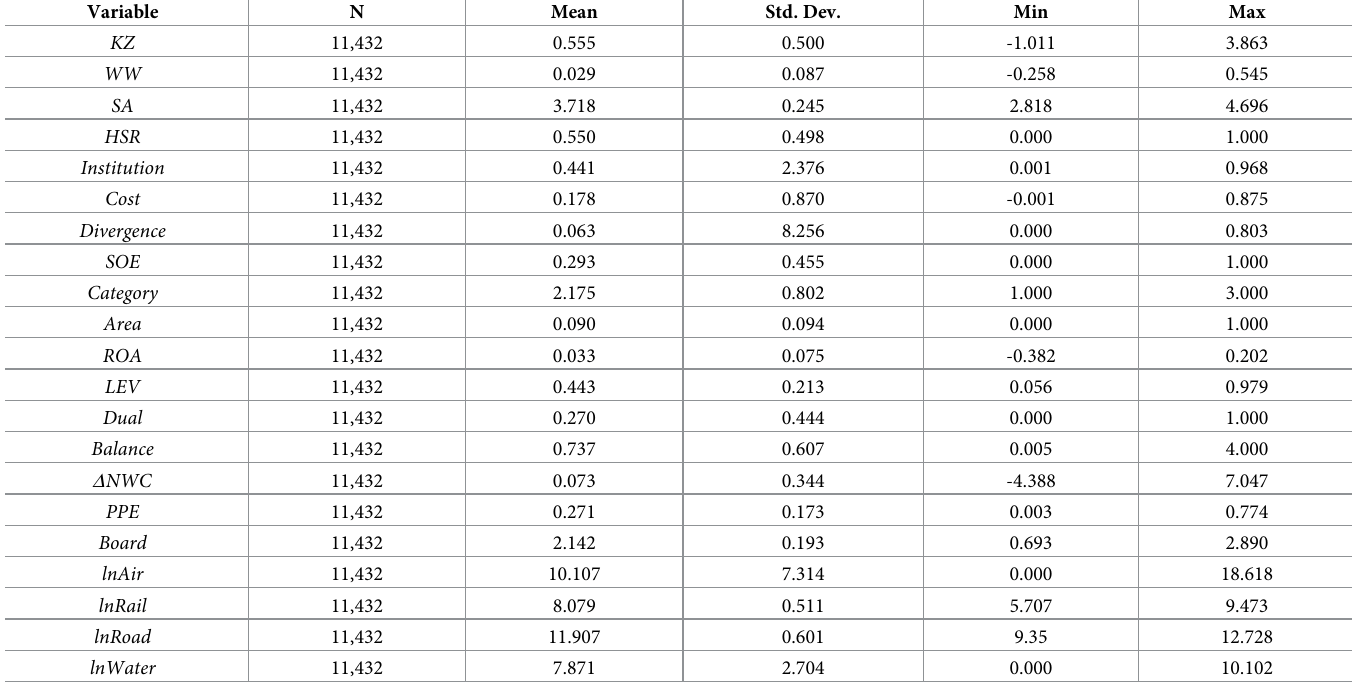
Table 2. Descriptive statistical results of main variables.